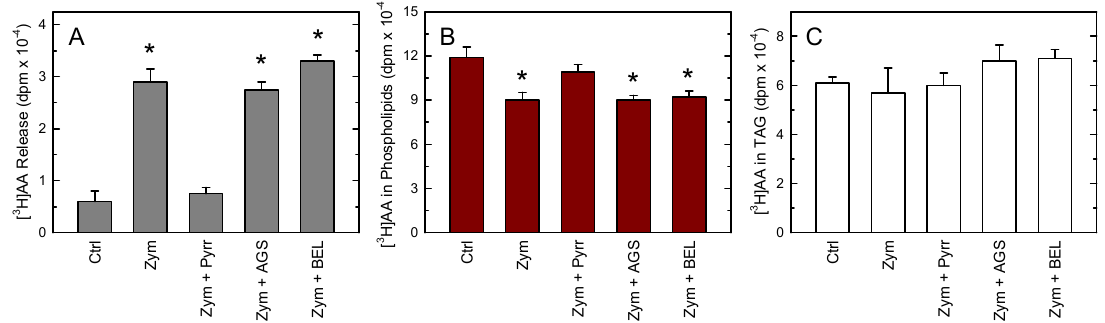
Figure 2. AA mobilization by zymosan-stimulated peritoneal macrophages. The [ 3 H]AA-labeled cells were either untreated (Ctrl) or stimulated with 0.5 mg/mL zymosan for 2 h in the absence (Zym) or presence of 1 µM pyrrophenone (Zym + Pyrr), or 20 µM atglistatin (Zym + AGS), or 10 µM bromoenol lactone (Zym + BEL). Afterward, the [ 3 H]AA released to the supernatants ( A ) or remaining in phospholipids ( B ) or TAG ( C ) was quantified as described in Materials and Methods. The data are expressed as mean values ± S.E.M. ( n = 6). * p < 0.05, significantly different from untreated cells.